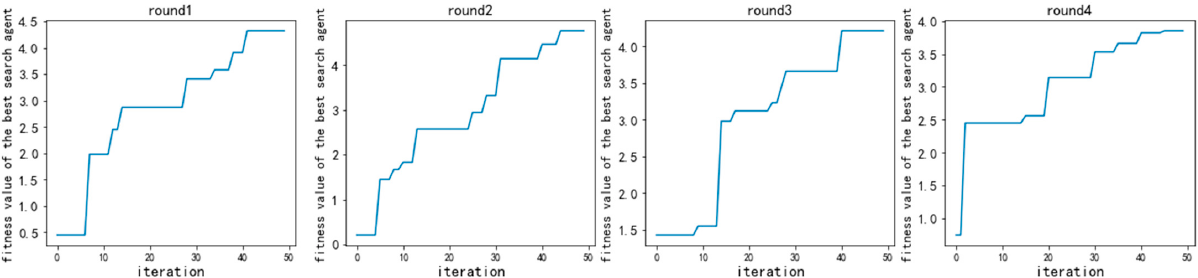
Figure 14. Comparison of fitness values of the best search agent obtained by four calls to WOAHC-L.